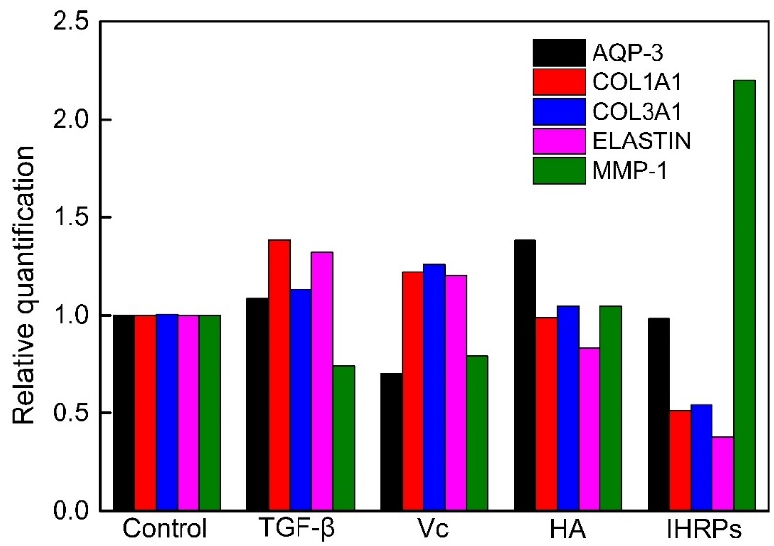
Figure 7. Relative quantification of the anti ‐ aging genes of HDF incubated with IHRPs.